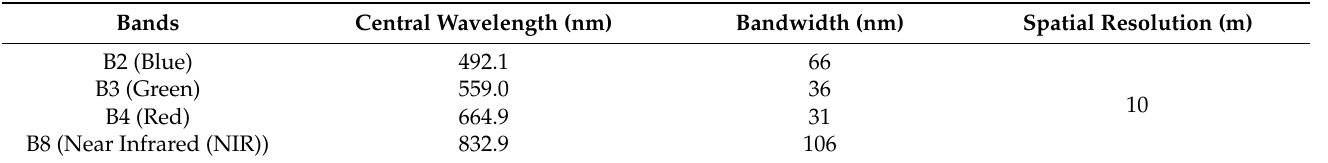
Table 3. Information about the bands used (adapted from